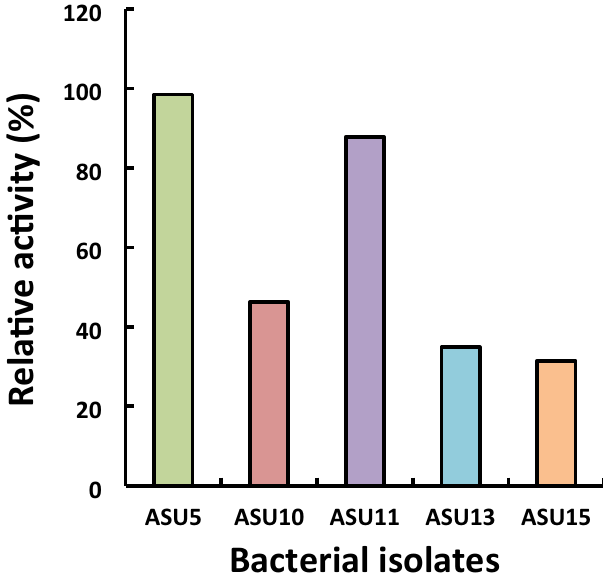
Figure 3. Effects of methanol on lipase enzyme produced by bacterial